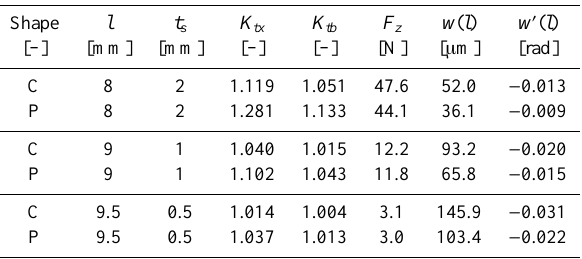
Maximum elastic deformation of circular (C) and parabolic (P) flexure hinges undergoing bending due to pure shear force F z